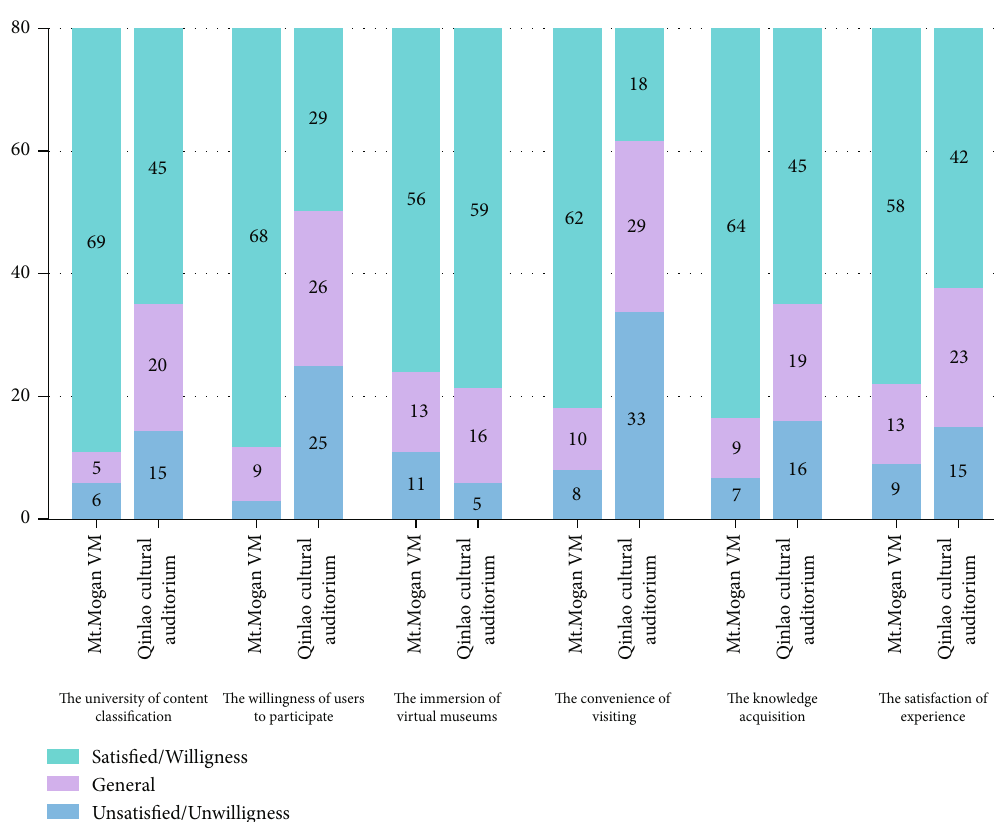
Figure 4: User experience comparison for the Mt. Mogan virtual museum and Qinlao cultural